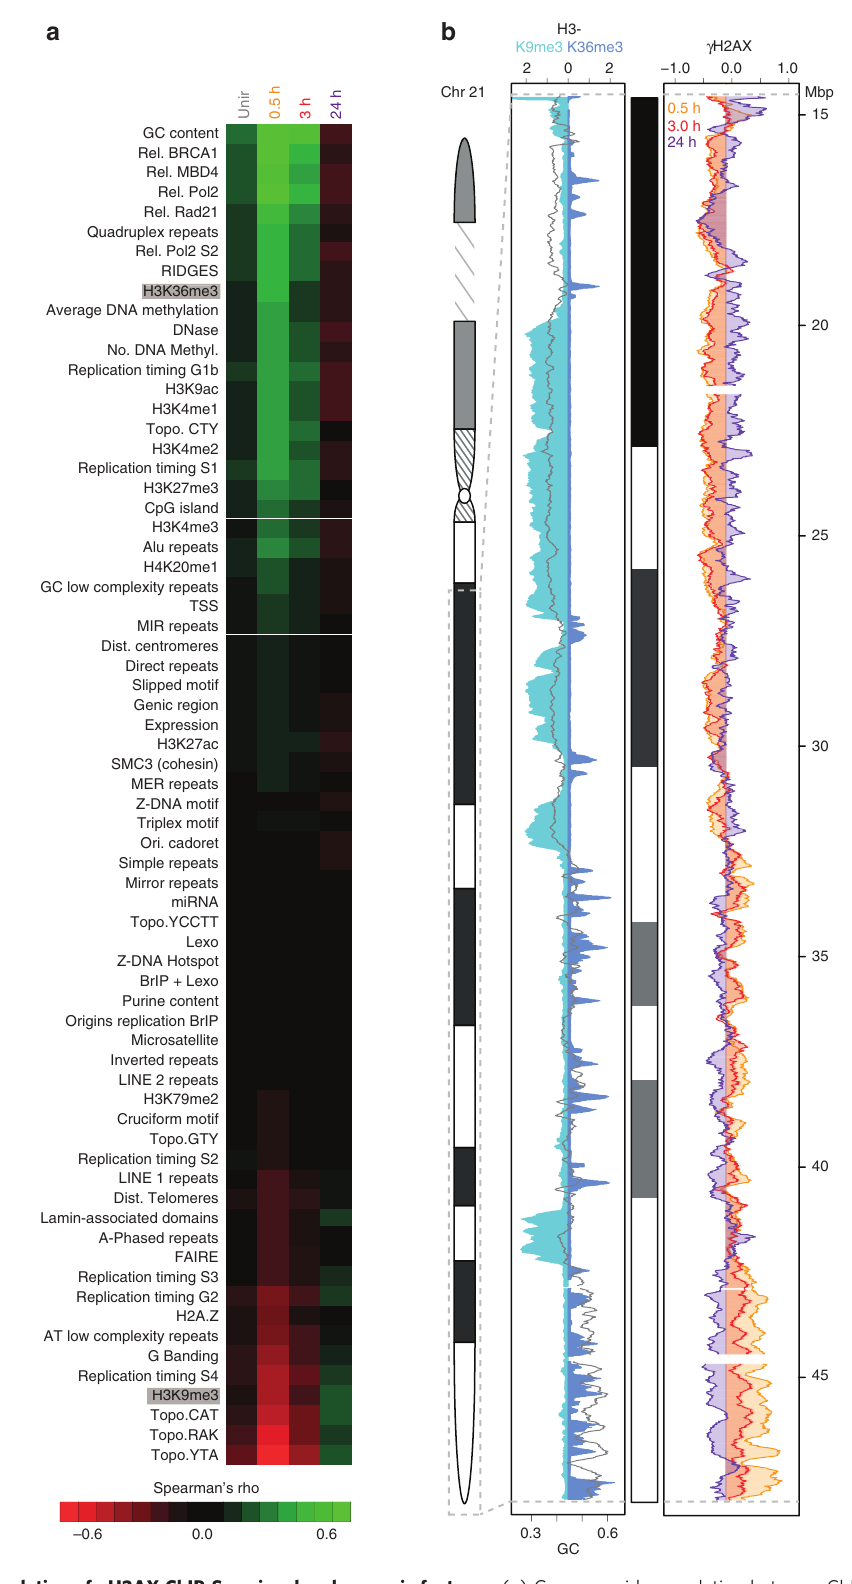
Figure 3 | Temporal correlation of c H2AX ChIP-Seq signal and genomic features. ( a ) Genome-wide correlation between ChIP-Seq g H2AX profiles and genomic features, before and during DDR. Spearman’s r correlation coefficient is calculated between 10kb-binned g H2AX profiles and the genomic features (Supplementary Table 3), and colour-coded from red (anti-correlation) to green (correlation). All genomic features are ordered decreasingly, according to the highest correlation value ( g H2AX and GC, 0.5h: 0.81). For all correlations: P oo 2.2 (cid:3) 10 (cid:2) 16 . ( b ) Exemplary ChIP-Seq g H2AX profile on chromosome 21. (left) H3K9me3, H3K36me3 and GC content (grey line); (right) g H2AX levels during